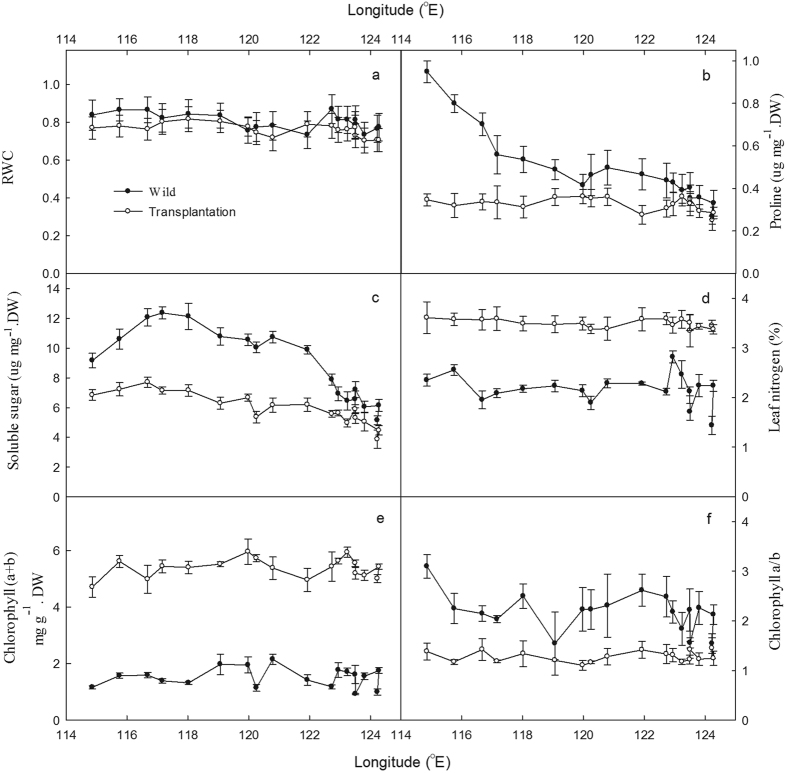
Physiological phenotypes of relative water content (RWC) (a), proline (b), soluble sugar (c), leaf nitrogen (d), chlorophyll (a + b) (e), and chlorophyll a/b (f) in wild sites and transplantation.